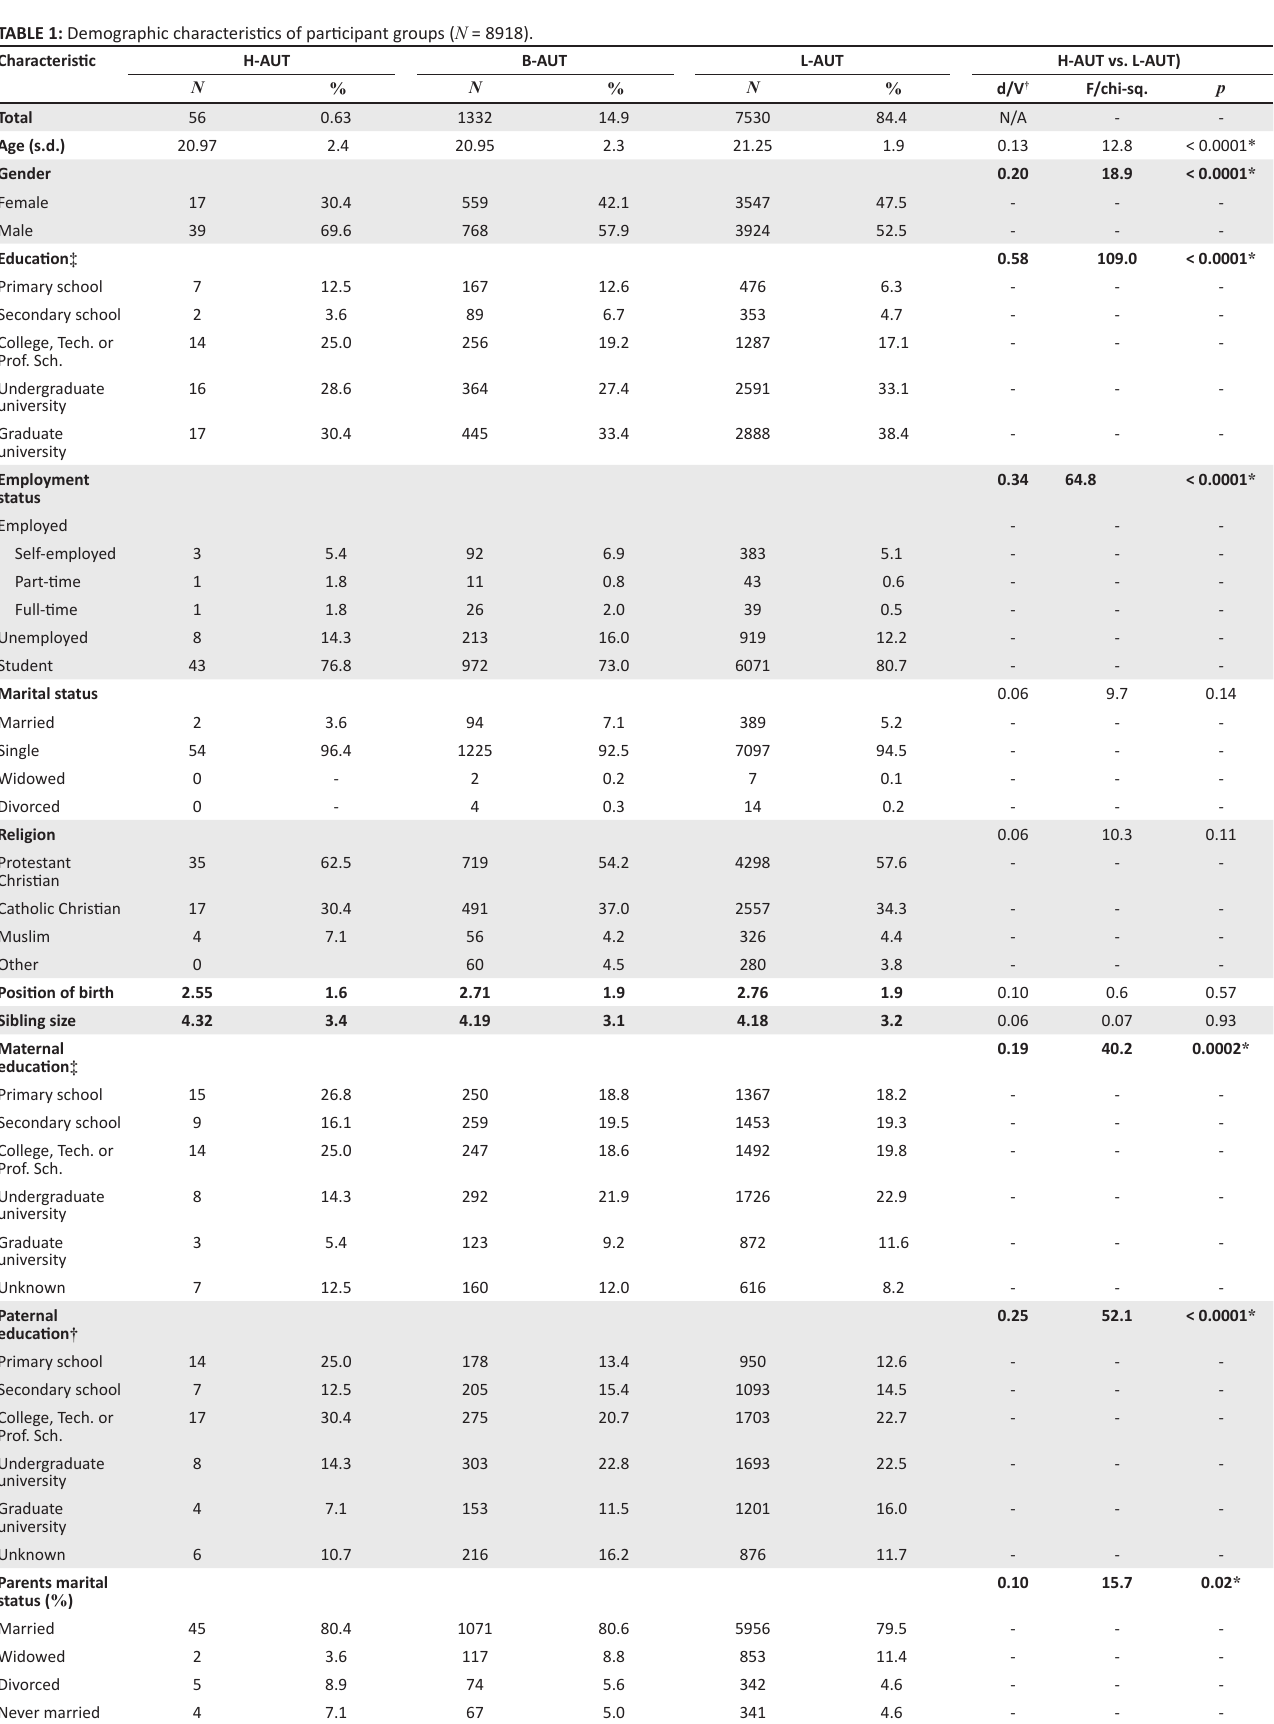
TABLE 1: Demographic characteristics of participant groups ( N = 8918).